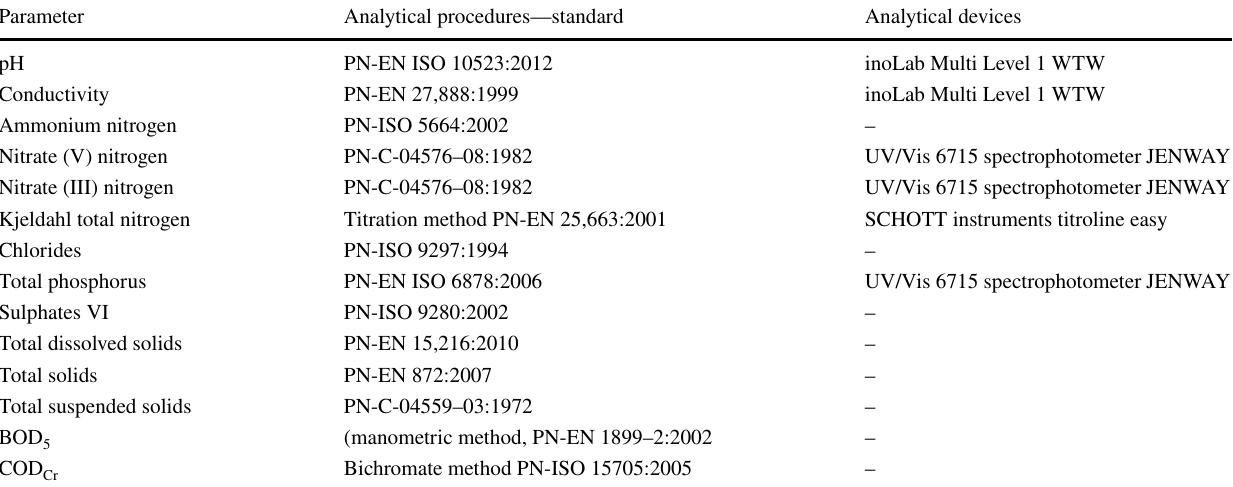
Table 1 Standard research